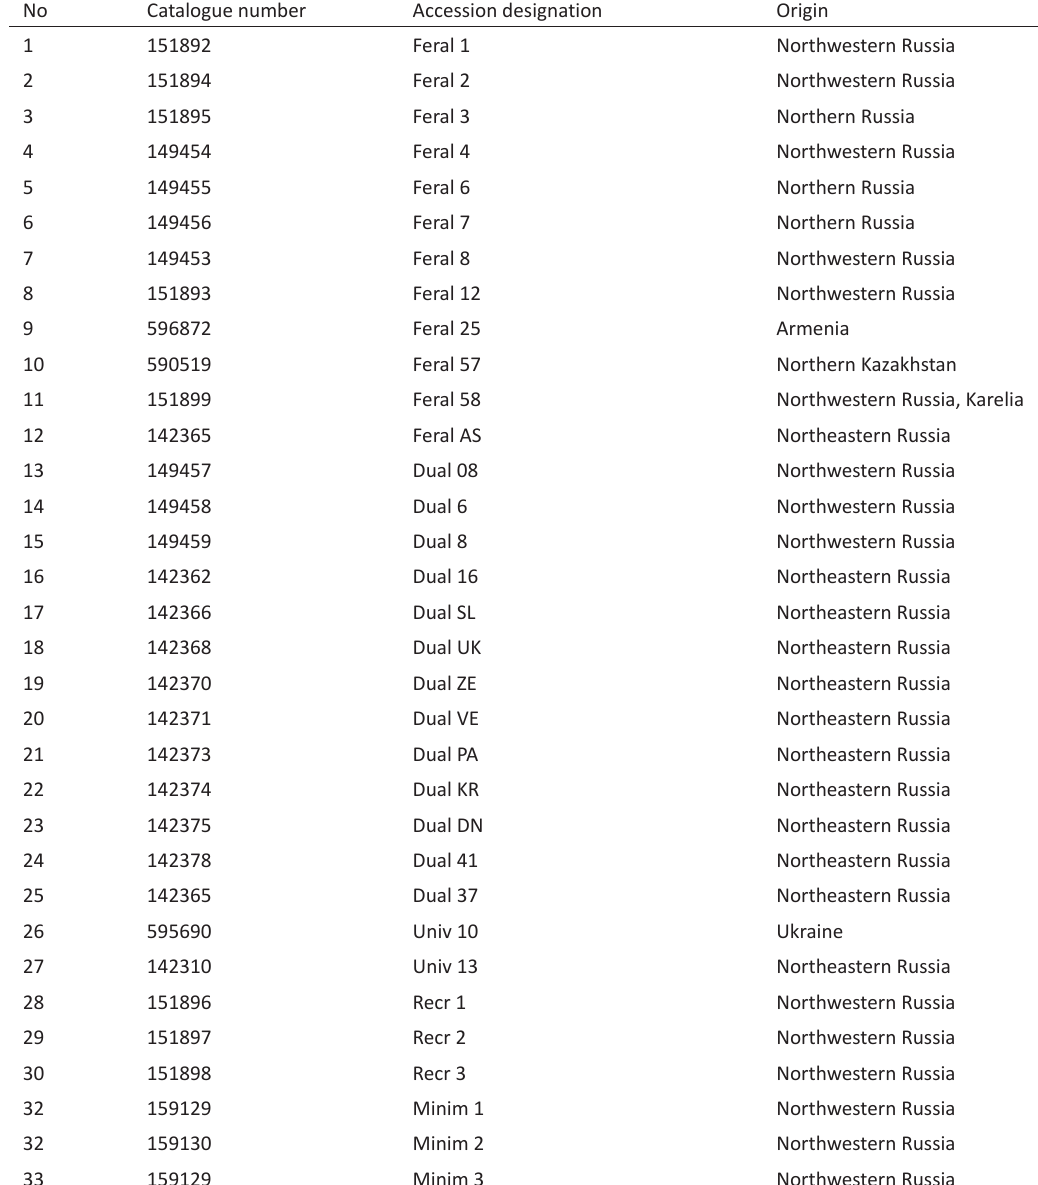
Table 1. Material for the research